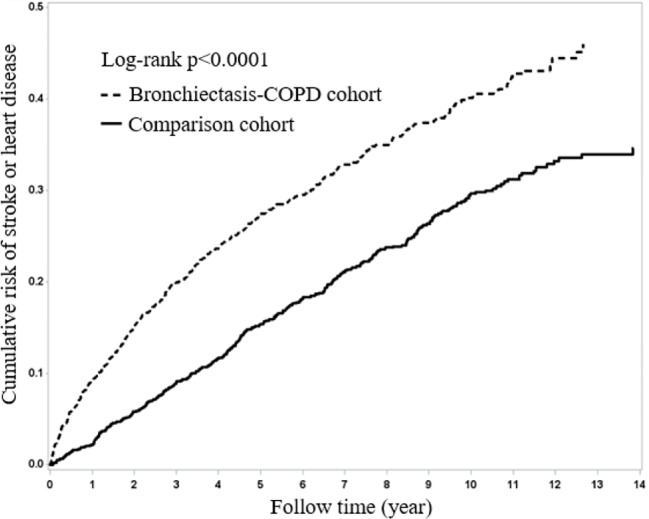
Kaplan–Meier curves of overall survival for the patients both with and without bronchiectasis-COPD (log-rank p < 0.0001).